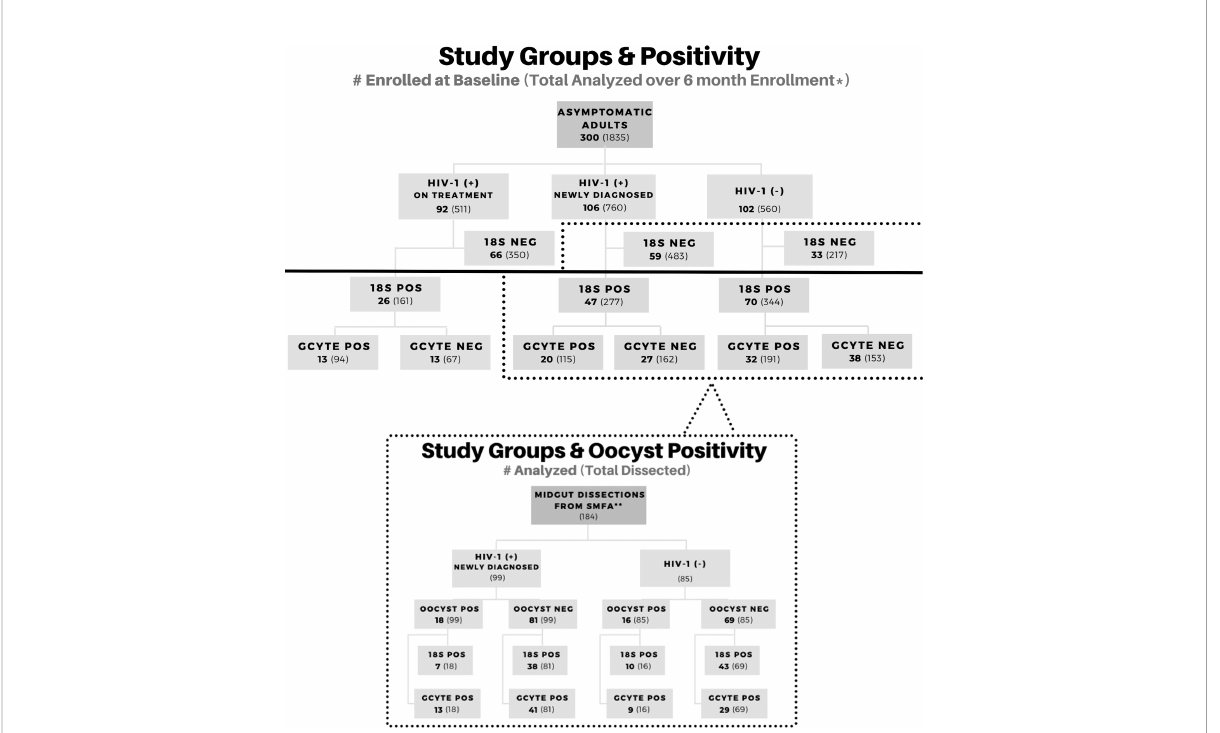
FIGURE 1 Study Pro fi le Overview. Participant enrollment by study group and corresponding molecular data for asexual and sexual parasite biomarkers. Groups below the solid black line were included in this study for gametocyte analysis. A subset of volunteers was enrolled in a transmission study using the Standard Membrane Feed Assay (dotted line). Positive samples are abbreviated as (+) or POS. Negative samples are abbreviated as (-) or